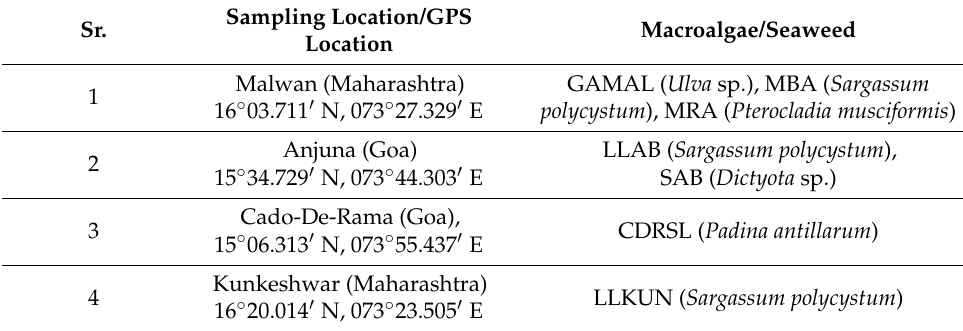
Table 1. Details of collected macroalgae samples with GPS coordinates.